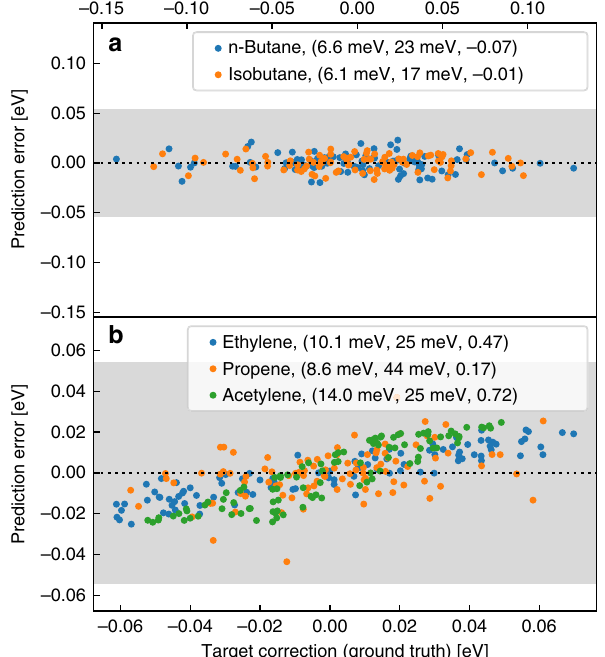
Fig. 4 Residuals for transferability task on small alkanes. a , b Values on the x -axis, the target corrections, correspond to the errors in total energy of PBE compared to the reference method CCSD(T). Prediction errors on the y - axis are de fi ned as the errors of NeuralXC optimized on ethane and propane with respect to CCSD(T). Shaded area corresponds to an error of ±2mH, the threshold chosen by Cheng et al. 26 . Values in parentheses correspond to (mean absolute error, maximum absolute error, R 2 for the